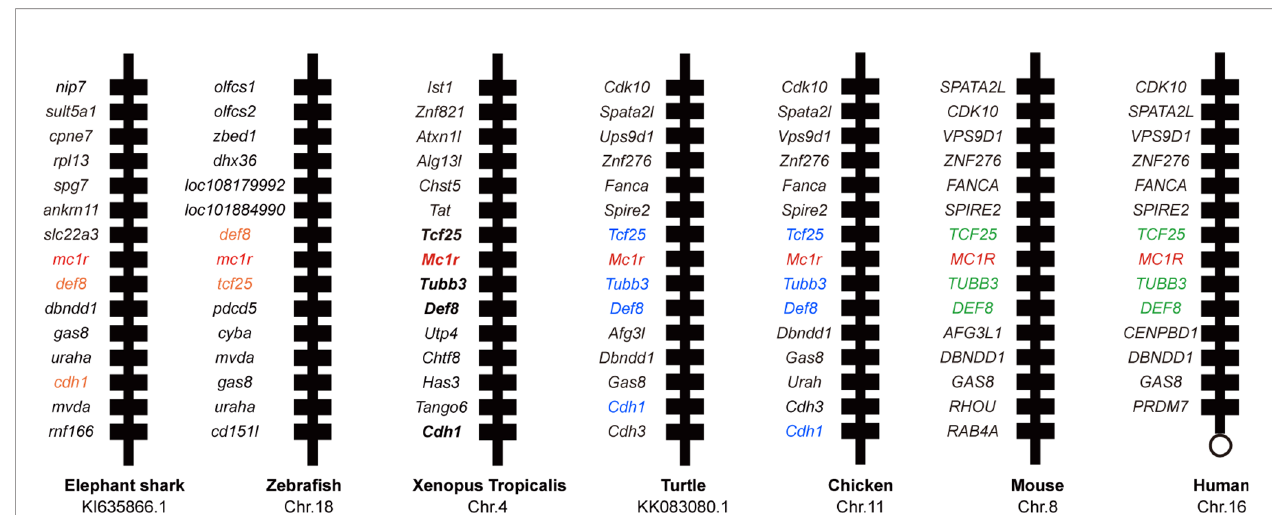
FIGURE 2 | Synteny analysis of Xenopus tropicalis mc1r . Synteny mapping of mc1rs among with Callorhinchus milii (elephant shark), Danio rerio (zebra fi sh), Xenopus tropicalis , Chrysemys picta bellii (turtle), Gallus gallus (chicken), Mus musculus (house mouse), and Homo sapiens (human). Positional conserved genes among multiple species are marked with color.